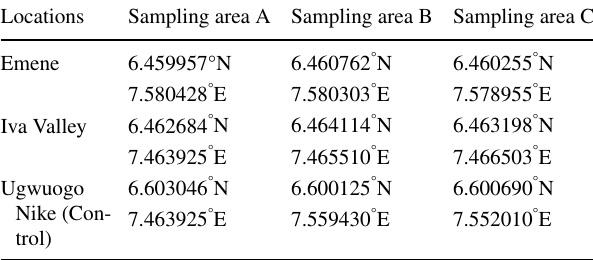
Table 1 Sampling locations with areas and coordinates Locations